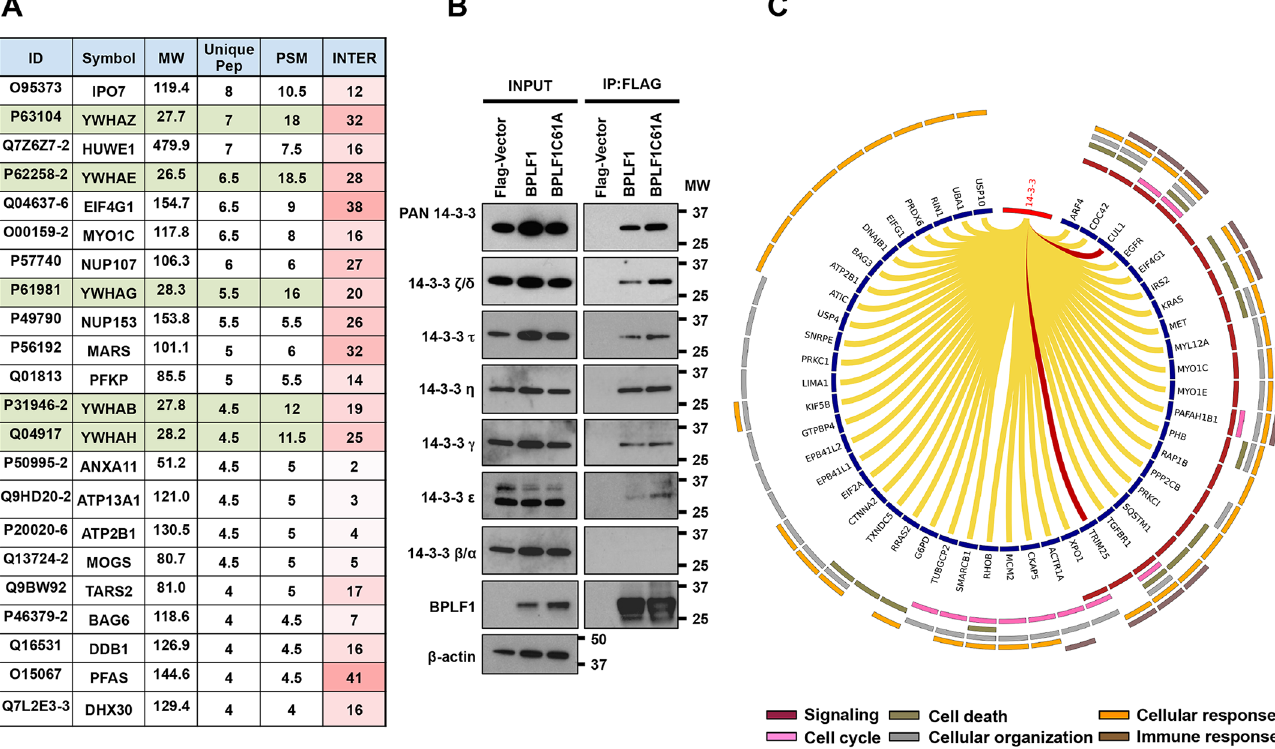
Fig 1. BPLF1 interacting proteins identified by tandem mass spectrometry. A . List of the 22 most abundant BPLF1 interacting proteins identified by mass spectrometry. The values are derived from the mean of two independent experiments. ID = protein ID, MW = molecular weight, Unique Pep = number of unique peptides mapping to the protein, PSM = number of peptide spectrums matched to the protein. INTER = number of annotated interacting proteins found in the BPLF1 interactome. 14-3-3 isoforms: YWHAZ = 14-3-3 z / δ , YWHAE = 14-3-3 ε , YWHAG = 14-3-3 γ , YWHAB = 14-3-3 β / α ,YWHAH = 14-3-3 η . B . The interaction of BPLF1 with the 14-3-3 isoforms was validated by immunoprecipitation and immunoblotting with the indicated isoform-specific antibodies. C . Circos diagram illustrating the annotated interaction of the 14-3-3 isoforms with other proteins enriched in the BPLF1 interactome. The two ubiquitin ligases found in the shared interactome, CUL1 and TRIM25, are highlighted in red. Color coded annotated functions are shown in the outer ring.